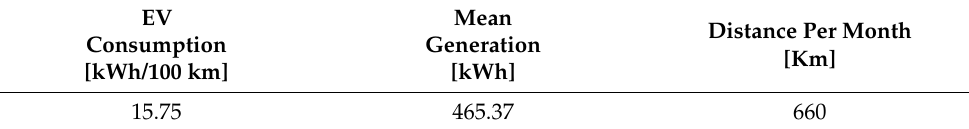
Table 7. Main parameters.